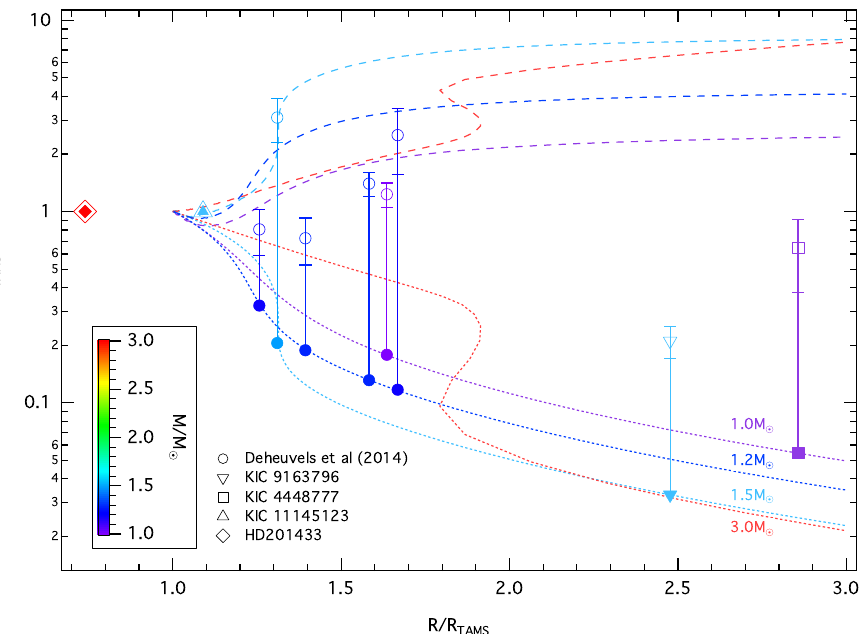
Figure 19. Mean core (dashed lines) and envelope (dotted lines) rotation rate during the evolution of YREC models (from the TAMS to the RGB) with various masses (colour coded) assuming local conservation of angular momentum and rigid rotation on the main sequence. The rotation rate and stellar radius are given relative to their respective values on the TAMS. The filled symbols correspond to the relative envelope rotation rates of various stars with a given mass and radius. The core rotation rate (open symbols) is determined from this value and the observed core-to envelope rotation gradient (Figure19 of Kallinger et al.